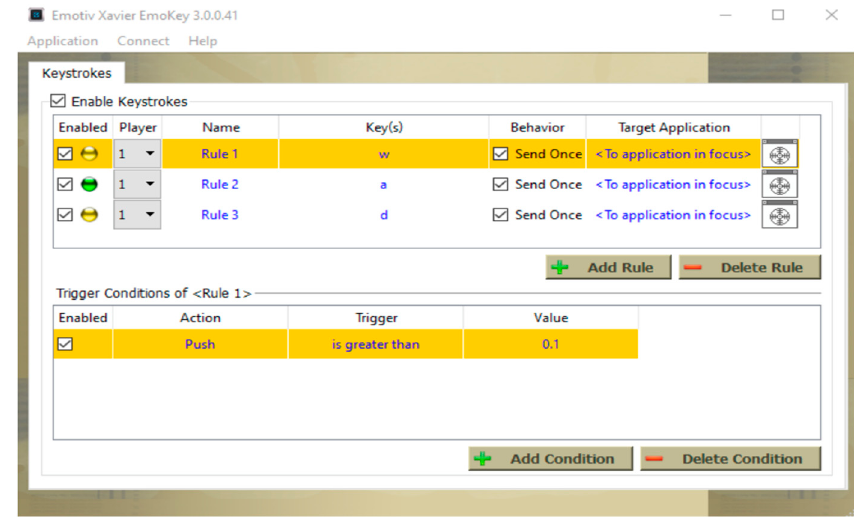
Figure 5. Emotiv EmoKey actions.